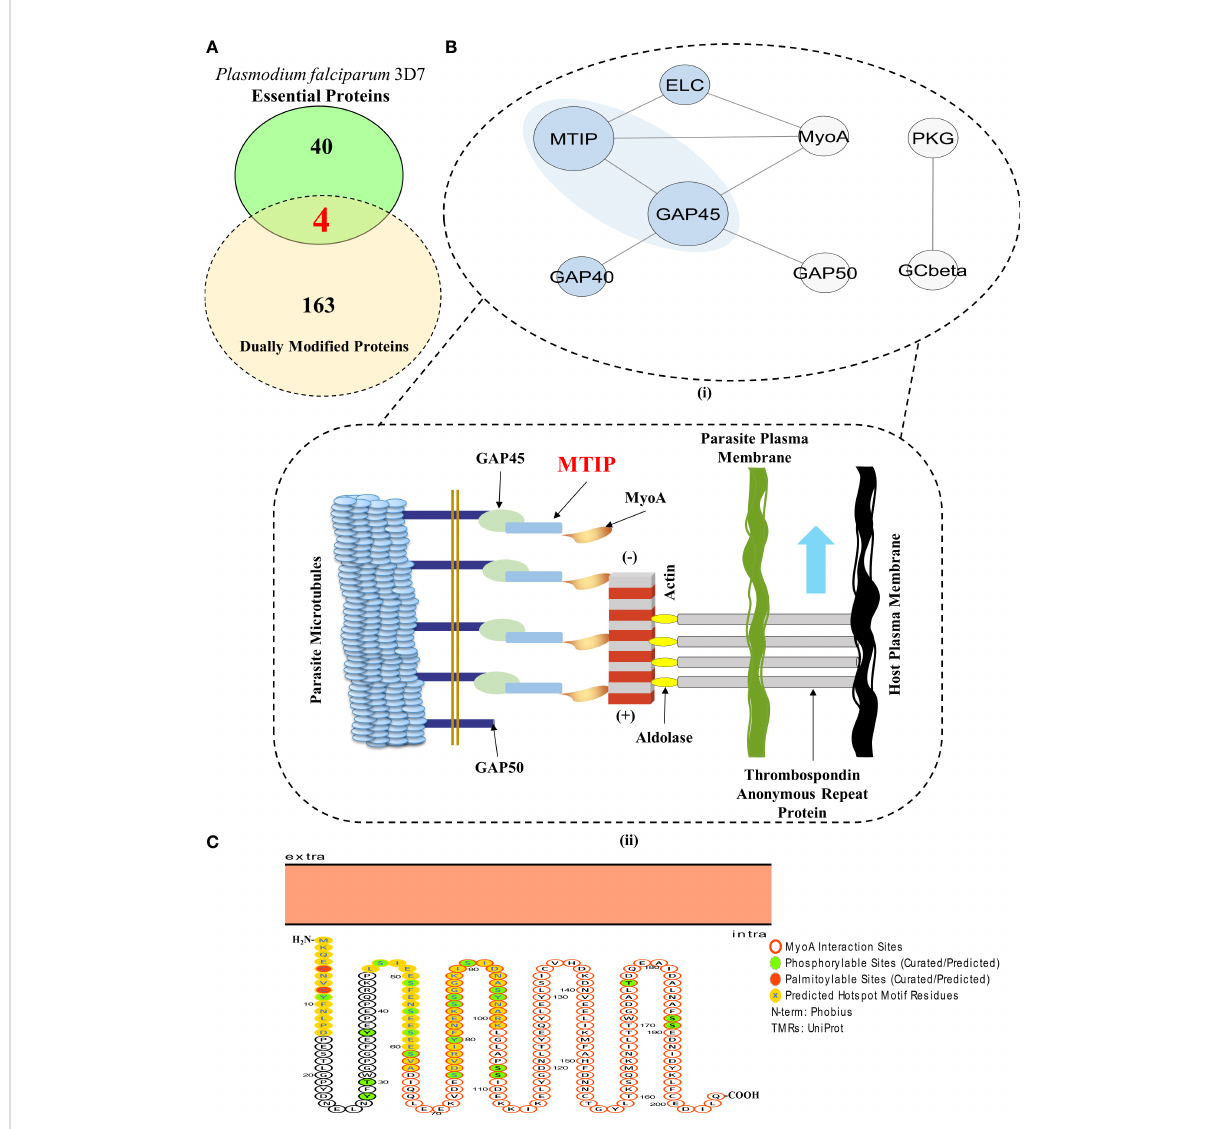
FIGURE 4 MTIP is an essential merozoite factor guiding parasite motility and erythrocytic invasion in hosts. (A) A Venn diagram showcasing the proteins which are dually modi fi ed by palmitoylation and phosphorylation and are essential for parasite survival. (Red fonts within the union of yellow and green ellipses; includes plasmepsin II, adenosine deaminase, calcium-dependent protein kinase 1 and myosin A-tail interacting protein). (B) (I) A STRING-generated PPI network of all the physical interactors constituting the glideosome motor complex. (Blue background) (II) An illustration of the actomyosin motor complex with MTIP as one of the central physical interactors. Revisualized from the published concepts of the glideosome motor unit (Bosch et al., 2006, Saunders et al., 2020). (C) A Protter generated illustration of MTIP showing the colocalization of phosphorylation and palmitoylation sites in the hotspots and MyoA interaction motif (Omasits et al., 2014, Anam et al.,